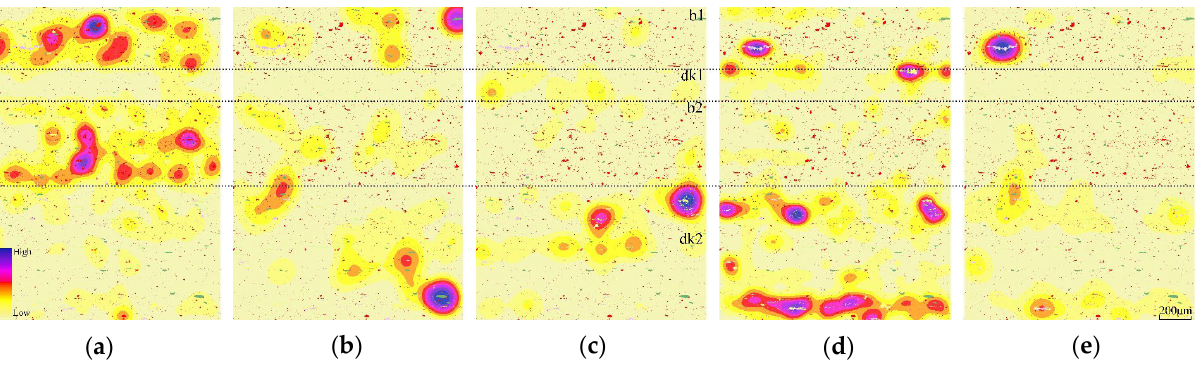
Figure 8. The kernel density maps of ( a ) pyrite, ( b ) alginite, ( c ) sporinite, ( d ) vitrinite, and ( e ) inertinite.